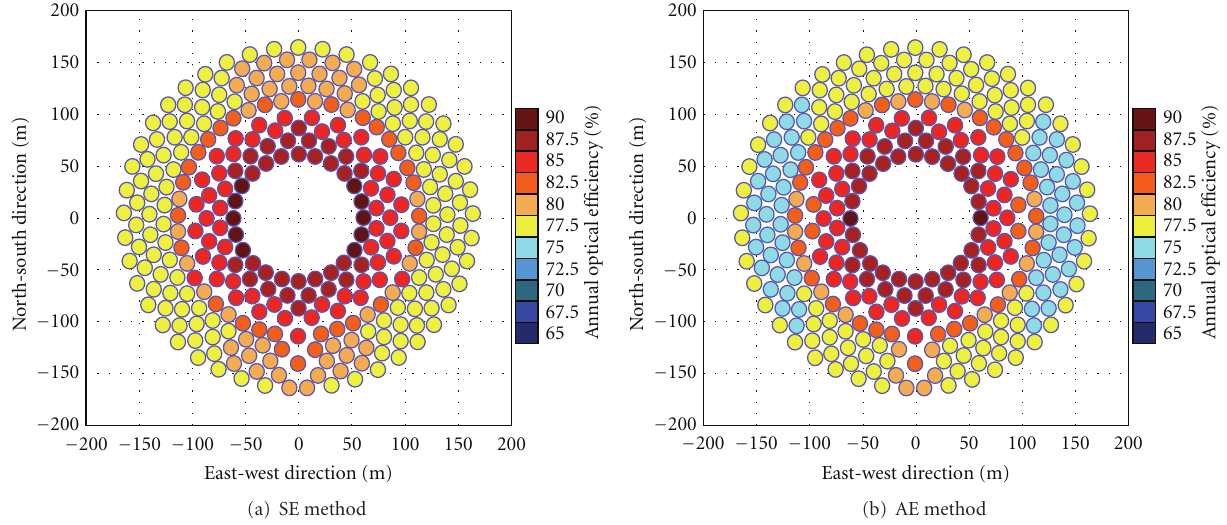
Figure 6: The annual optical e ffi ciency of heliostat in the case of latitude 0 ◦ .